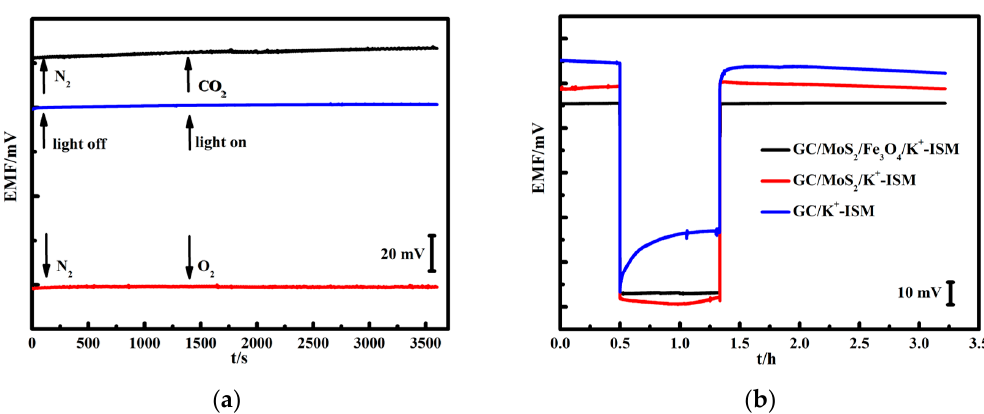
Figure 4. ( a ) Light, O 2 , and CO 2 interference tests of GC/MoS 2 /Fe 3 O 4 /K + -ISE in 0.1 M KCl. ( b ) Water layer tests of GC/K + -ISE, GC/MoS 2 /K + -ISE, and GC/MoS 2 /Fe 3 O 4 /K + -ISE.